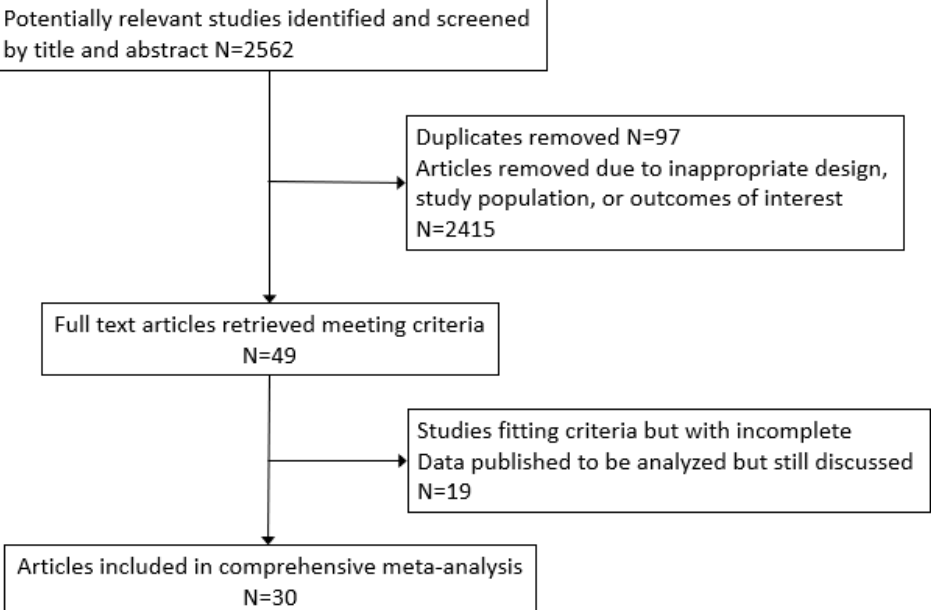
Figure 1. Flowchart of studies included in meta-analysis.